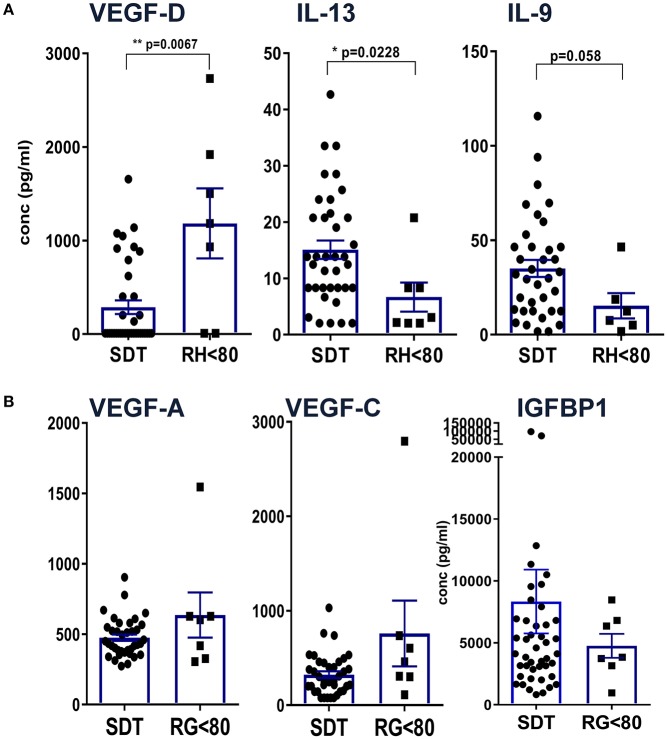
Definition of differences between patients with complete hearing loss vs. residual hearing capacity. Patients were grouped according to their acoustical performance at the time of CI with a hearing cut-off of <80 for patients with residual hearing (RH) vs. complete deafness (surditas SDT). Mann-Whitney-u-tests were performed for (A) VEGF-D, IL-13, and IL-9 and (B) VEGF-A, -C, and IGFBP1, respectively, with differences p < 0.05 defined as significant and marked with (*) and p < 0.001 with (**).